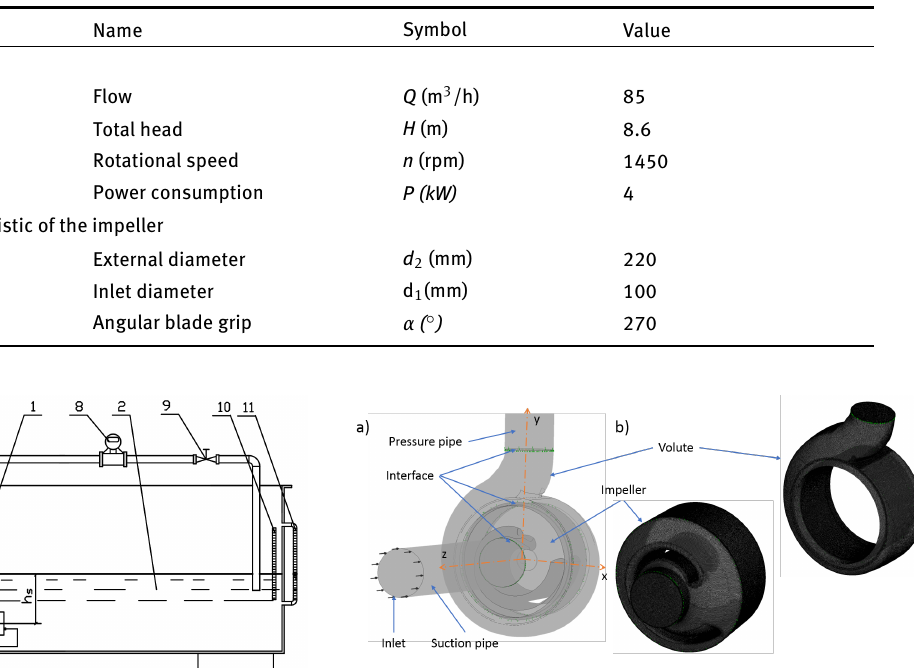
Figure 2: The scheme of the test rig: 1 – model pump, 2 – open tank, 3 – control box, 4 – discharge pipe, 5 – elastic pipe, 6 – power me- ter, 7 – manometer, 8 – flowmeter, 9 – regulation valve, 10 – ther- mometer, 11 – level indicator with bypass In Fig. 4 the comparison of the results of the numerical calculations and experimental tests in relative coordinates